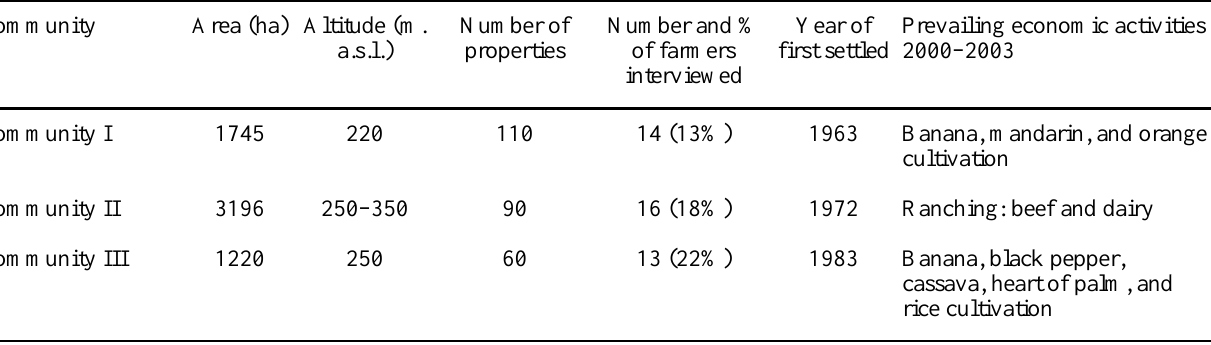
Table 3. Salient information concerning the three communities studied (adapted from Millington and Bradley 2008). Note, in previous publications, the communities have been given the names of Caracas (I), Bogotá (II), and Arequipa